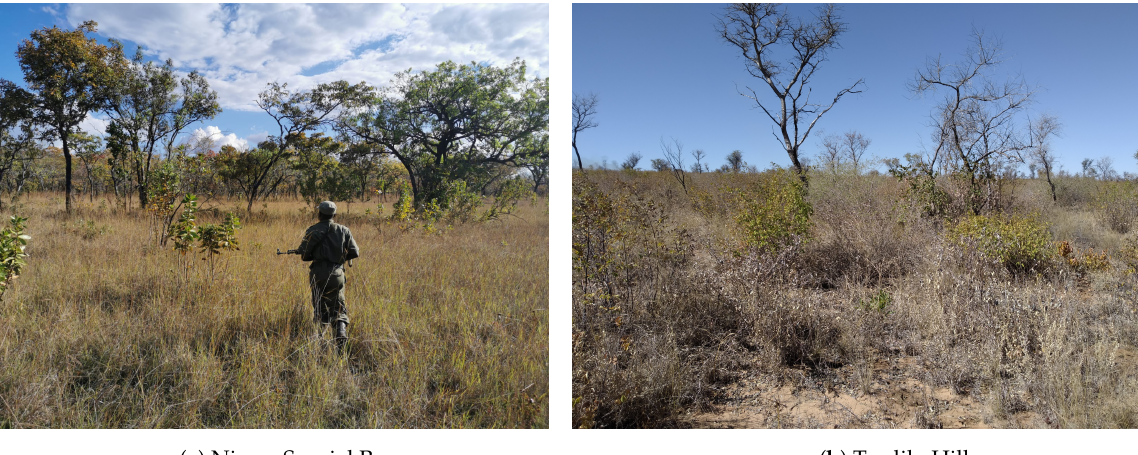
Figure 2. Example landscapes in the Early Dry Season (EDS) in ( a ) Niassa Special Reserve and ( b ) Tsodilo Hills. Pic- tures taken by T. Eames and R.